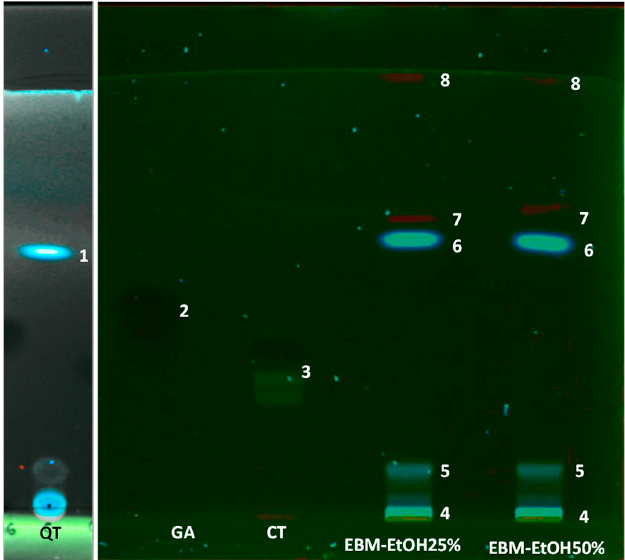
Figure 5. Analysis TLC of EBM-EtOH25% and EBM-EtOH50%. GA (gallic acid standard), CT (+ catechin standard) and QT (quercetin standard). UV light at 366 nm.